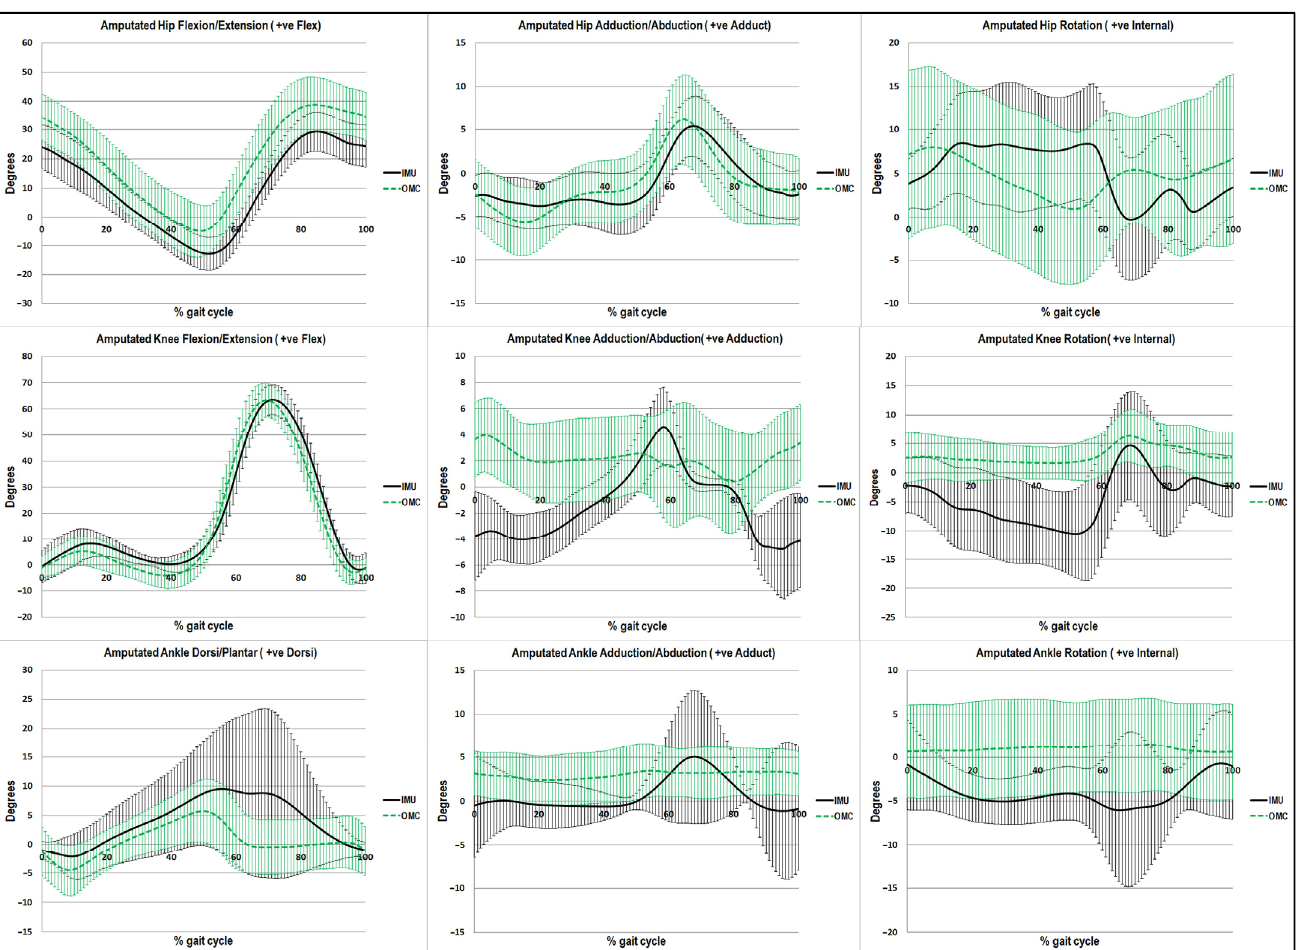
Figure 5. The visual waveform of walking kinematics on the amputated side . The black lines represent IMU and the green lines represent OMC. Note: IMU: Inertial Measurement Unit, OMC: Optical Motion Capture.